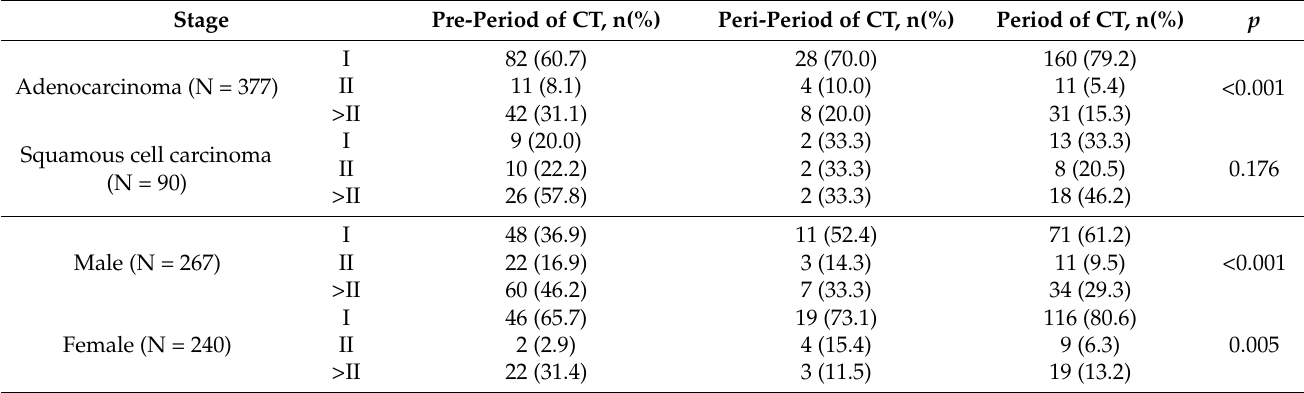
Table 2. Effect of routine CT examination on early diagnosis of lung cancer.